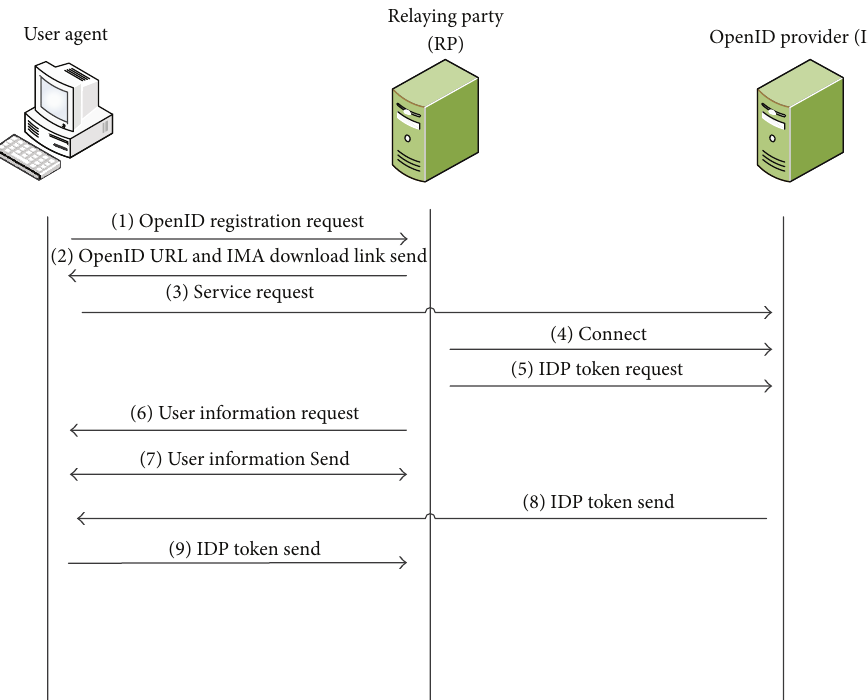
Figure 4: Data flow of the proposed